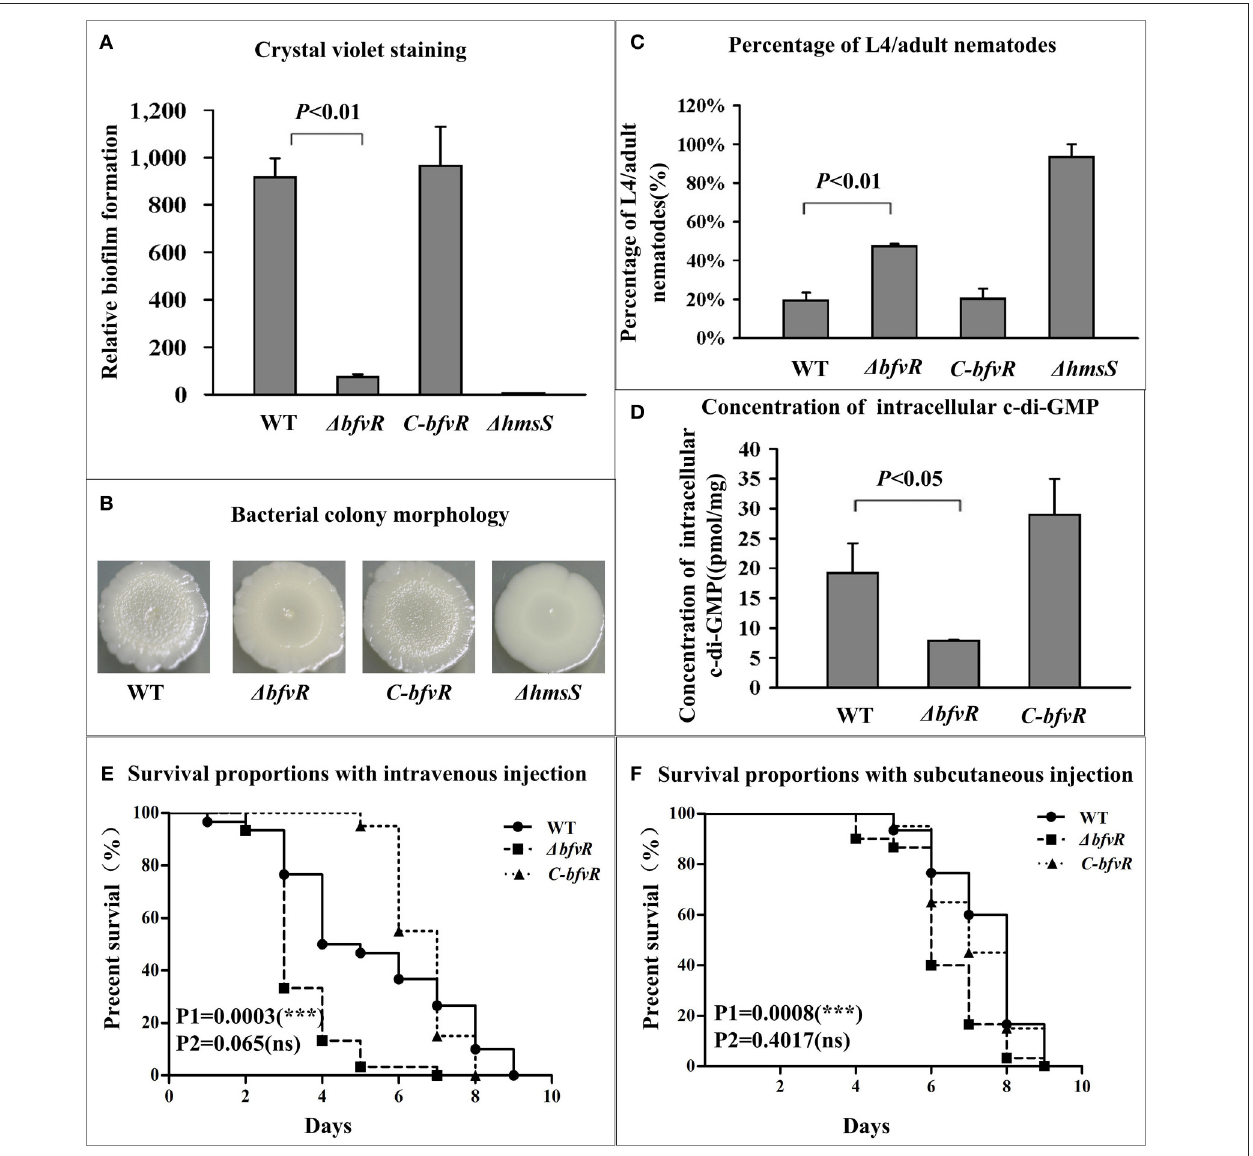
FIGURE 1 | BfvR-mediated phenotypes. (A) Crystal violet staining of biofilms. Cultured for 48h in 24-well polystyrene dishes and evaluated by the OD570/OD620 value. (B) Bacterial colony morphology. Spotted on the LB agar with the glycerol stocks and cultured for 1 week at 26 ◦ C and then analyzed. (C) Biofilms on nematodes. Calculated by the percentage of L4/adults after 48-h feeding with different strains. (D) Intracellular c-di-GMP concentrations. Isolated c-di-GMP from the logarithmic bacteria and determined the concentrations by UPLC-MS/MS. (E,F) Virulence in BALB/c mice. Infected with 50-150 CFU by intravenous injection via the tail vein (E) and the subcutaneous injection at the inguinal region (F) and evaluated the virulence by the survival curve and P value with the GraphPad Prism 5.0 software. This is a representative experiment. P1 and P2 represented the P values between WT and ∆ bfvR or C-bfvR , respectively. *** Shows significant difference, ns indicates no significant